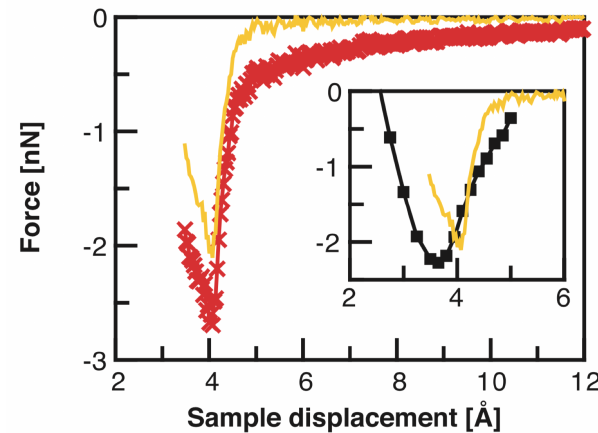
Figure 7. Total force (red line with symbols) and short-range force (yellow line) determined above the adatom site labeled 2 in Figure 1. In the inset, the measured short-range force is compared with a first principles calculation [36] (black line with symbols, see Figure 6). Adapted with permission from American Association for the Advancement of Science from Figure 2C in